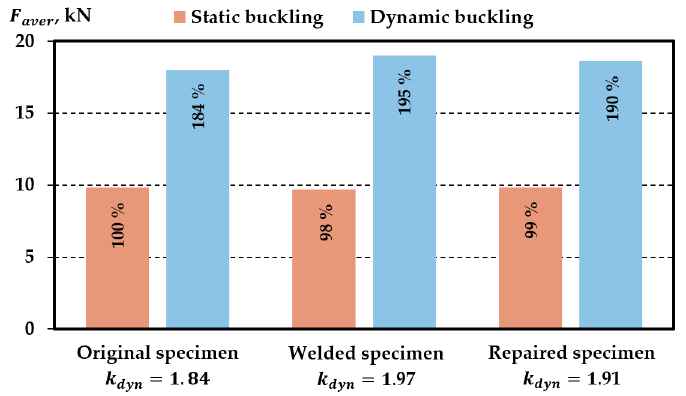
Figure 19. Dependence of the average buckling force on the nature of the load.